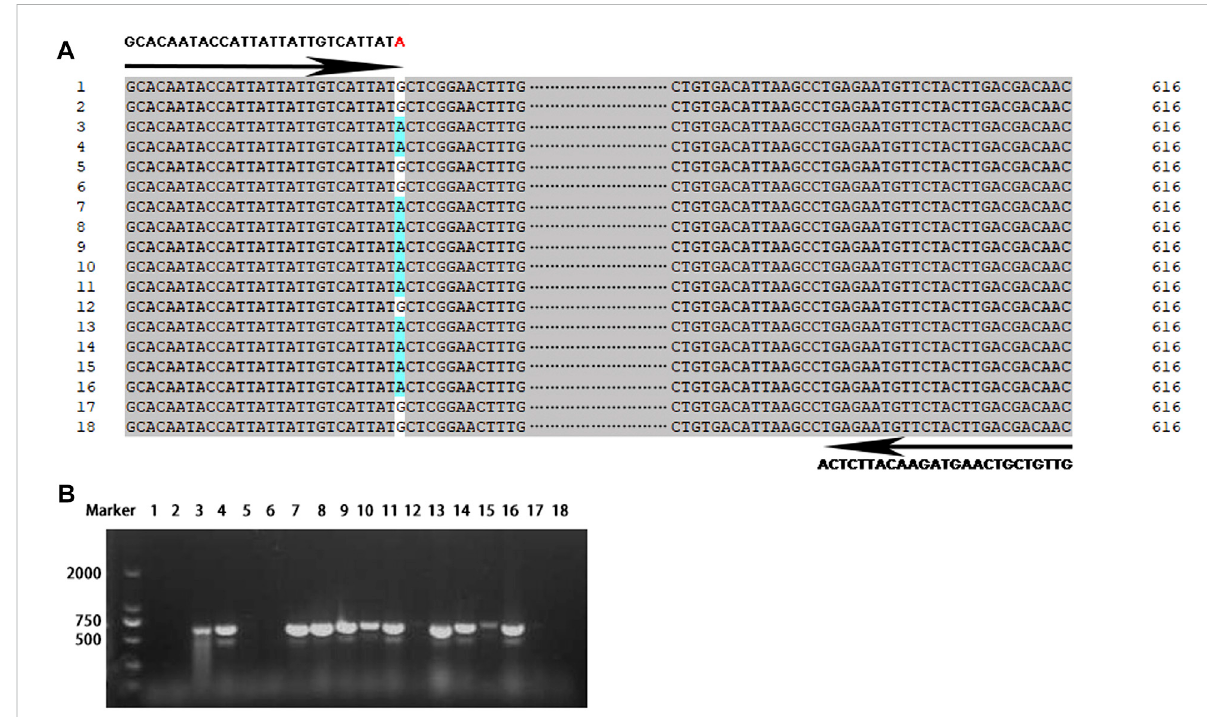
FIGURE 4 Development and validation of the FNP-based molecular marker. (A) Primer set (Pi-d2-S/AS) designed to target the FNP site that distinguished resistant and susceptible alleles with an expected PCR-ampli fi ed product of 616 bp. The numbers shown at the left of each sequence were referred to the landraces in Supplementary Table S2. The functional nucleotide polymorphic site of landrace 3, 4, 7 – 11, 13 – 16 was adenine (A) highlighted in blue. (B) PCR based validation of the primer set in eighteen landraces by PCR. M: marker. 1 – 18: landraces referred in Supplementary Table